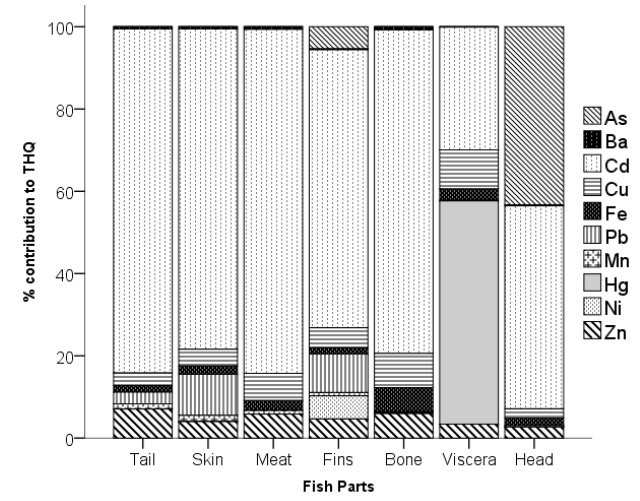
Figure 4. Percent (%) contribution of HMs to the THQ per body part.